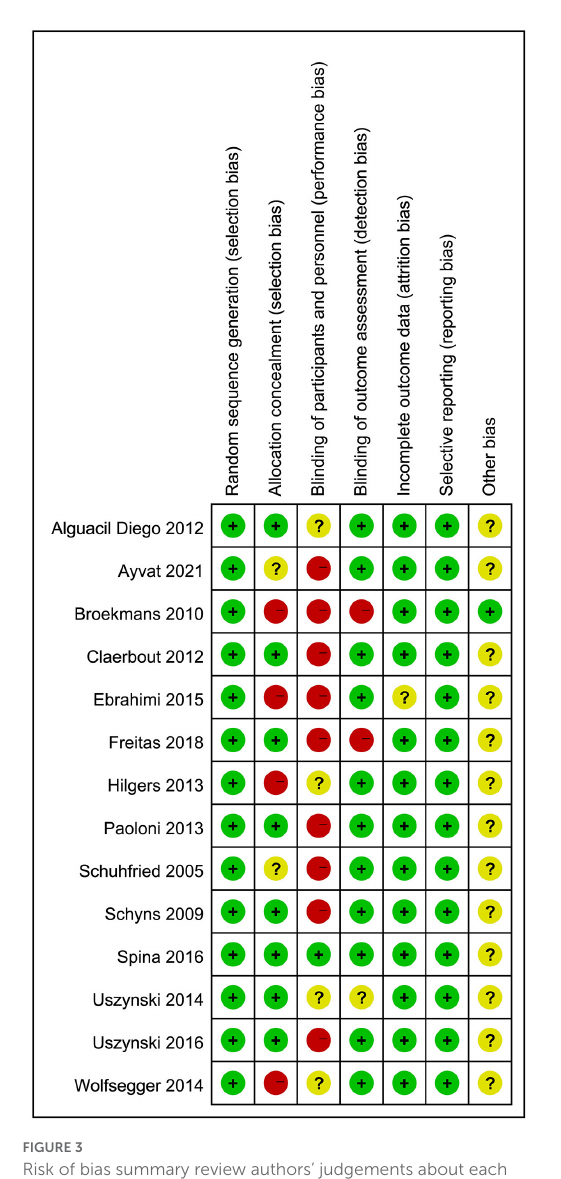
95% CI: 0.33–4.07, P = 0.02) (Figure 5). However, only